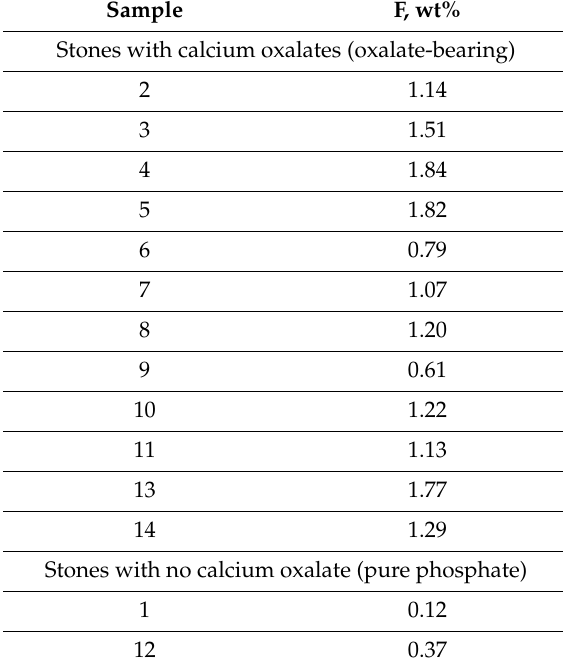
Table 4. Average fluorine concentrations in the studied urinary stones. Sample F,